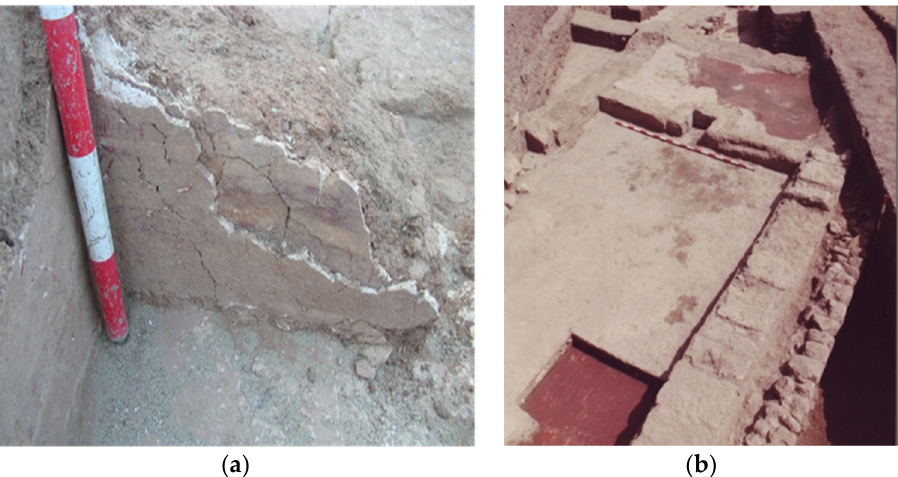
Figure 1. Layers of lime mortar tinted with almagra in Late-Islamic Córdoba: ( a ) Antonio Maura Street (Castillo Pérez de Siles 2003); ( b ) Palacio de Orive (Murillo et al. 1992).